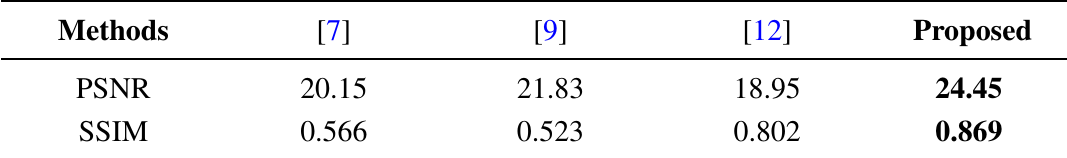
Table 2. Comparison of PSNR and SSIM values of the resulting images using three existing SR and the proposed SR